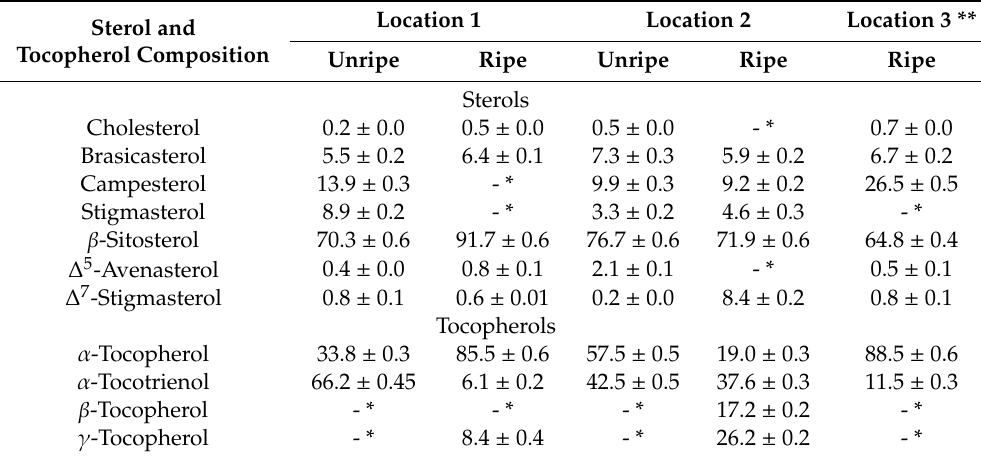
Table 4. Sterol and tocopherol composition of the lipid fraction of J. excelsa unripe and ripe galbuli from the three collection sites in Bulgaria (mean ± SD),